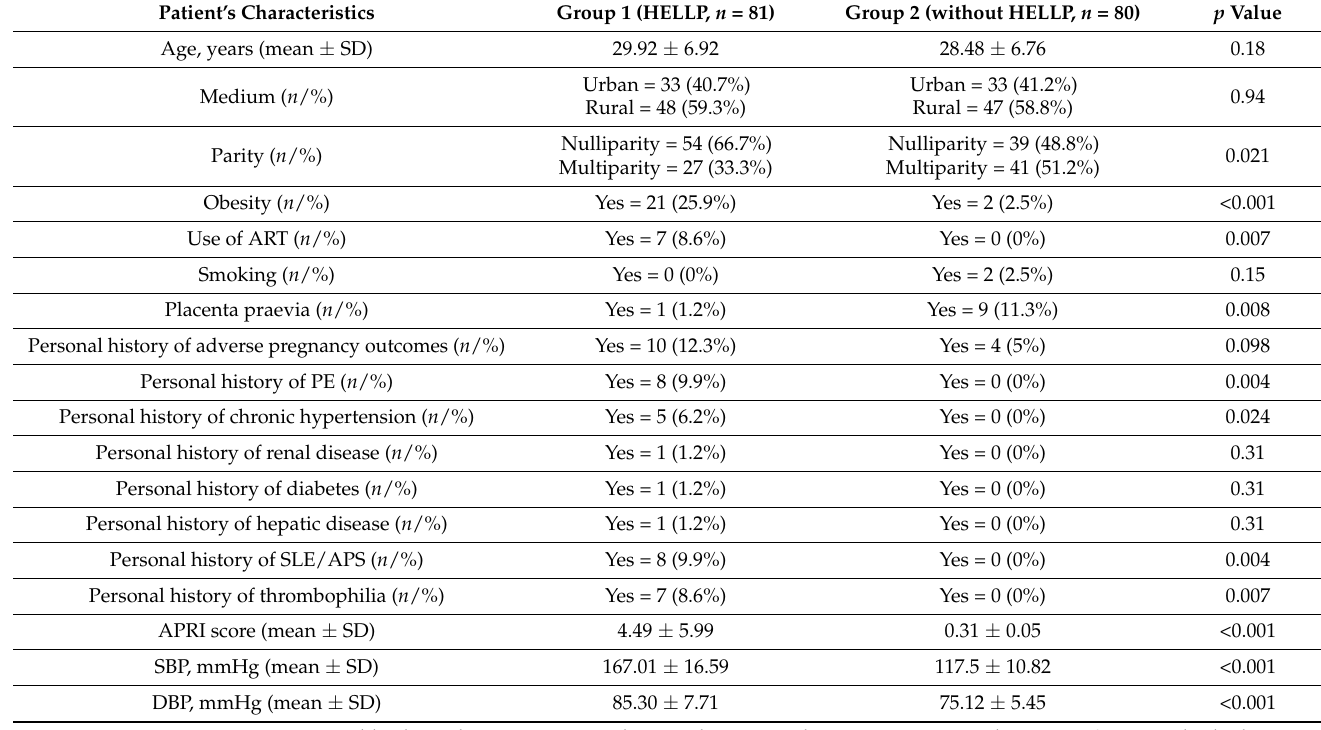
ART—assisted reproduction techniques; PE—preeclampsia; SD—standard deviation; APS—antiphospholipid syndrome; SLE—systemic lupus erythematosus; APRI—aspartate-aminotransferase to platelet ratio index; SBP—systolic blood pressure; DBP—diastolic blood